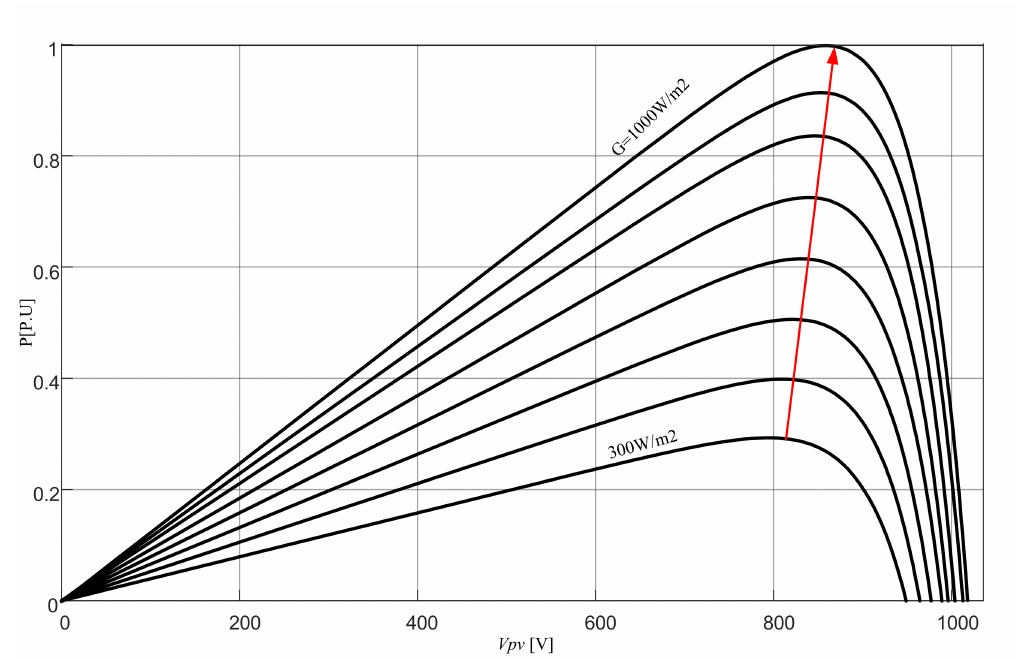
Figure 3. Ppv- v pv characteristics curves of the PV generator at different solar